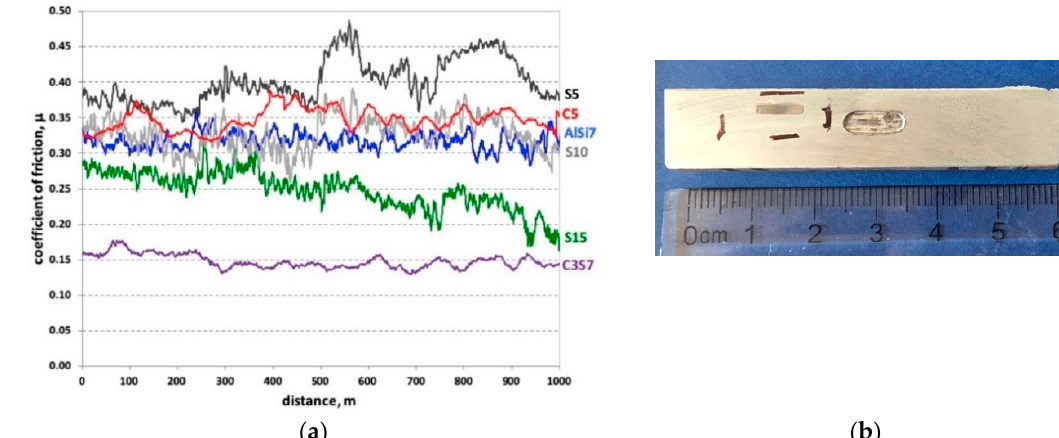
Figure 8. Friction coefficient ( μ ) versus sliding distance for un-reinforced matrix alloy (AlSi7) and different single (S5, S10, S15 and CS) and hybrid (C3S7) composite layers detailed in Table 2 ( a ); View of sample cut from the un-reinforced sleeve with a visible wear trace after tribological test ( b ).